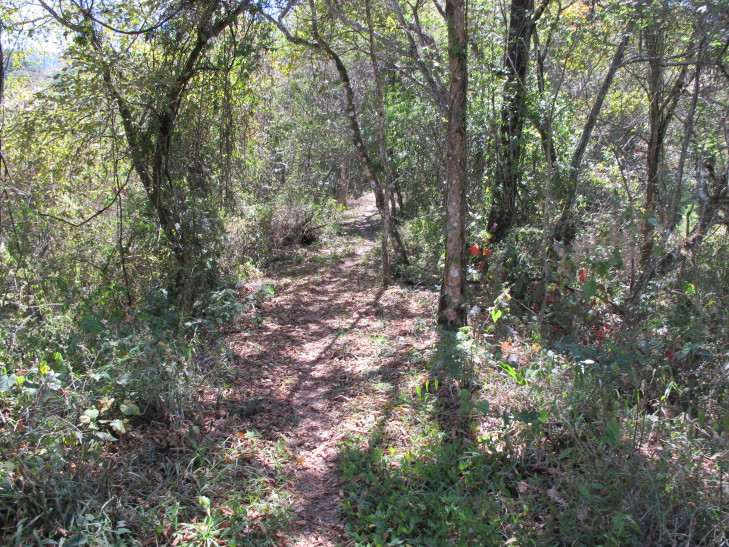
Brachypelma
vagans habitat, Mexico. Photo: Jorge Mendoza.